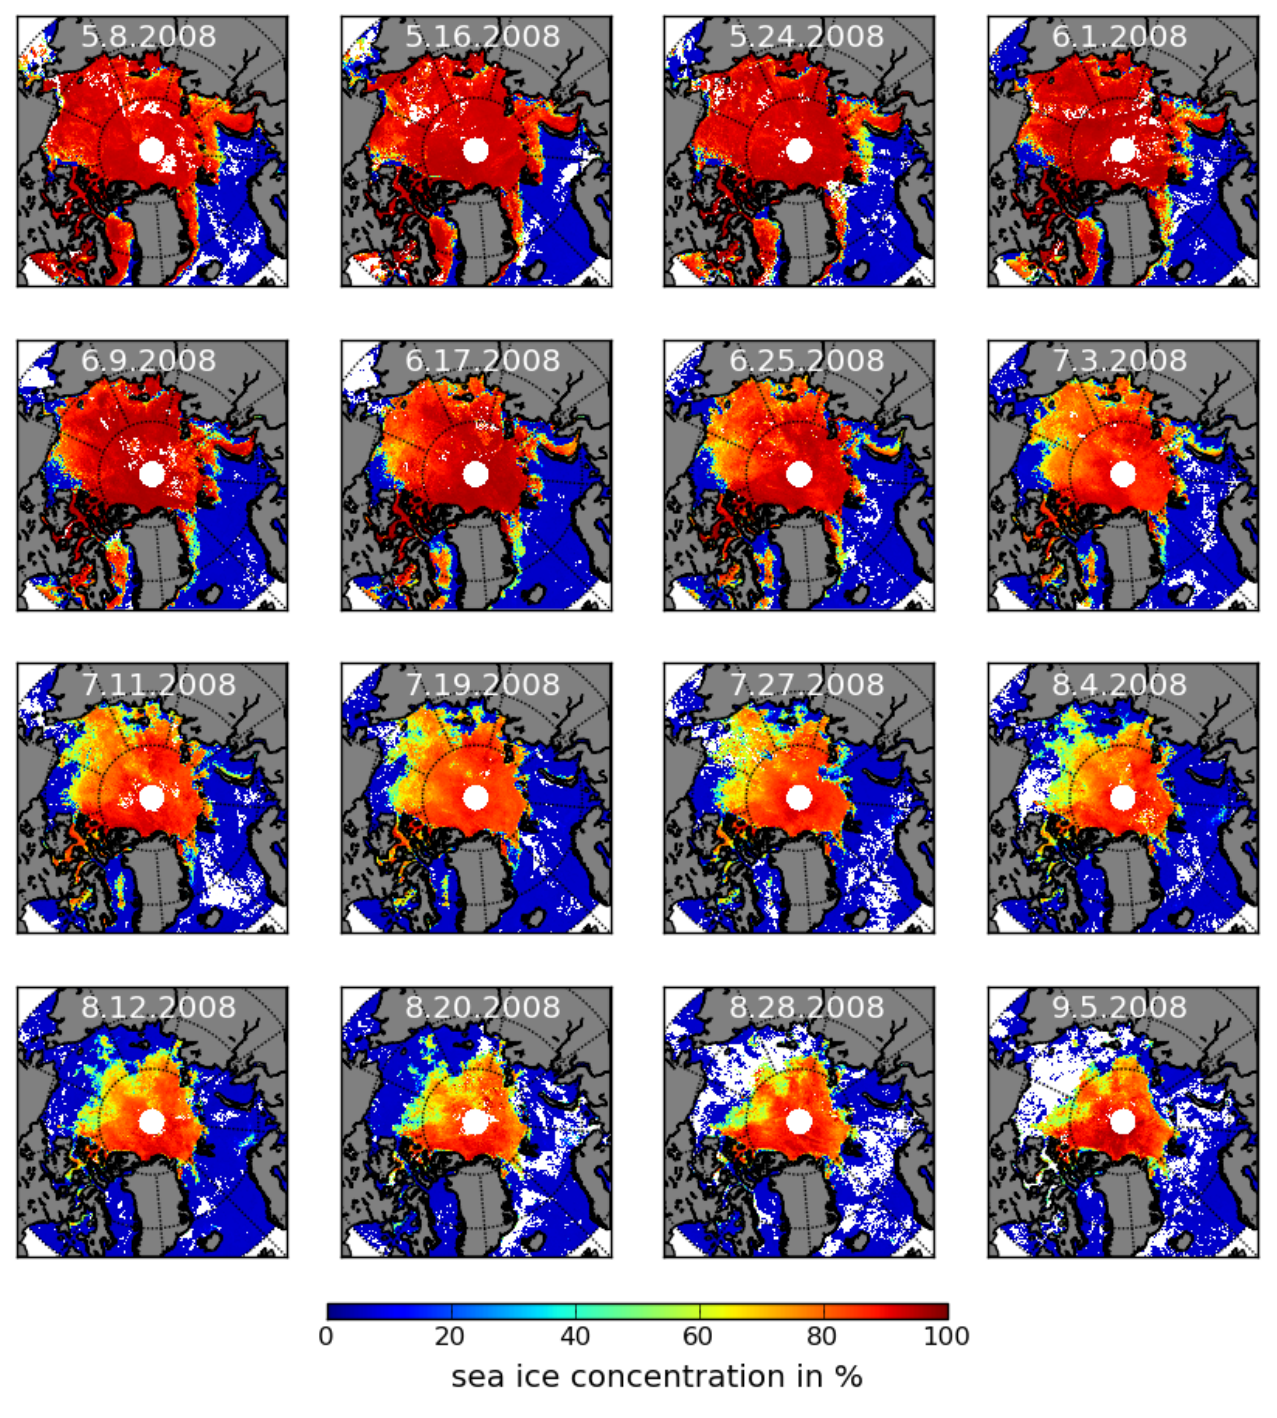
Fig. 5. Seasonal cycle of the sea ice concentration from MODIS satellite data for the Arctic for the example of the 2008 melt season. White pixels represent missing data.